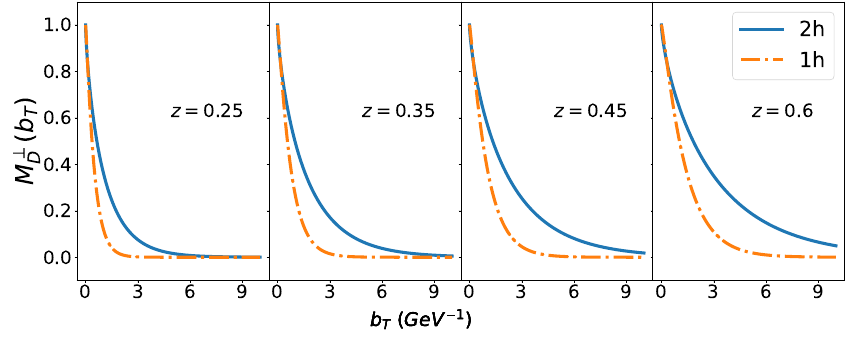
parametrizations in b -space: T D